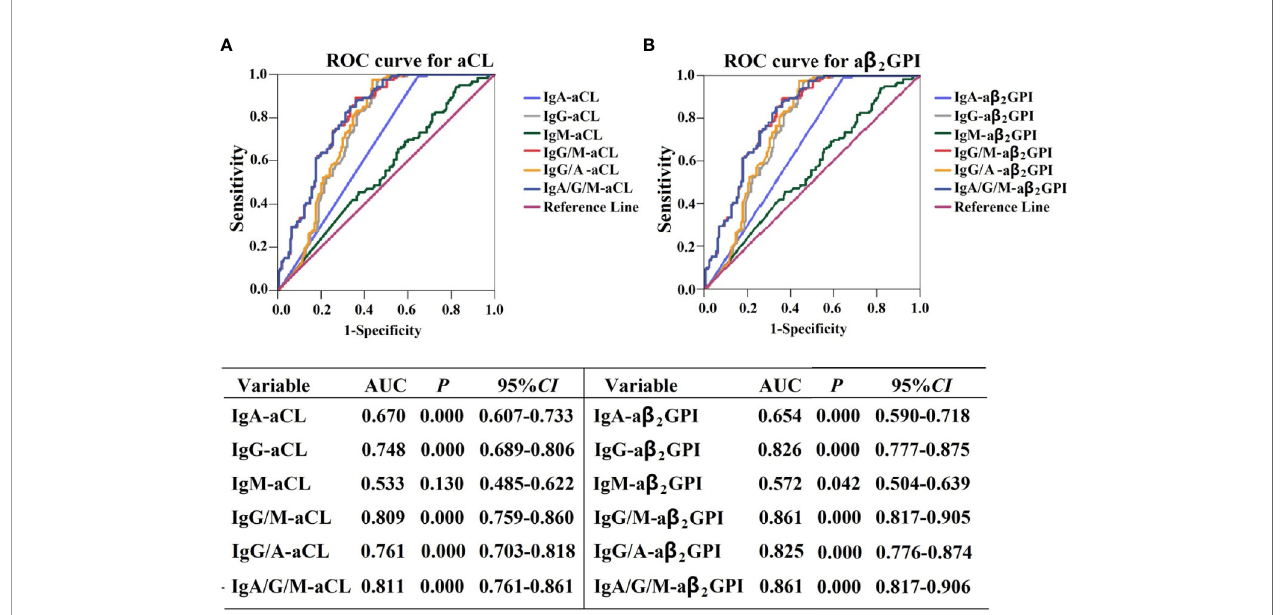
FIGURE 3 | Receiver operating characteristic curve analysis of the aPL isotype in APS patients. (A) ROC curve for aCL and (B) ROC curve for a b